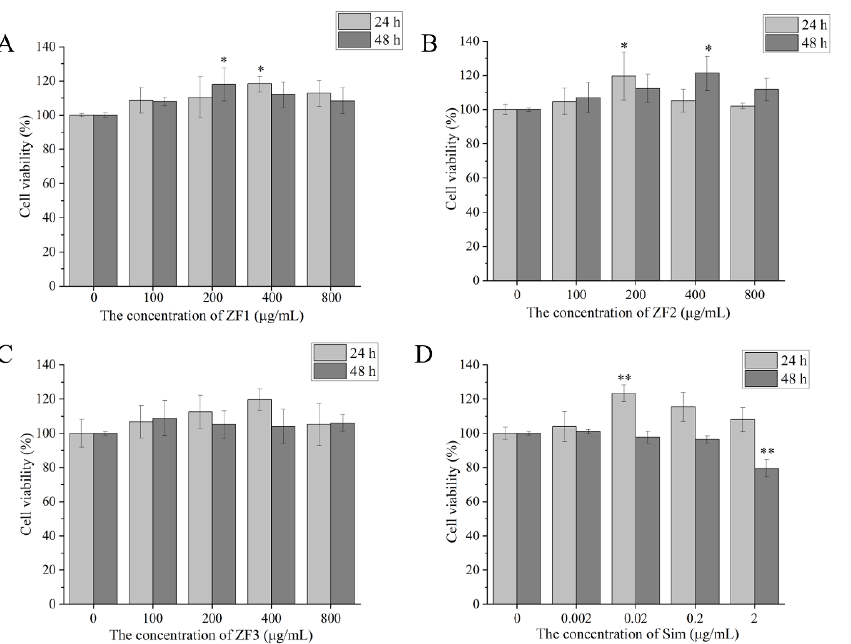
Figure 6. The viability of HepG2 cells treated with different concentrations of ZF1, ZF2, ZF3, and Sim for 24 h and 48 h. ( A ) The viability of HepG2 cells treated with different concentrations (0, 100, 200, 400, and 800 μ g/mL) of ZF1 for 24 h and 48 h; ( B ) the viability of HepG2 cells treated with different concentrations (0, 100, 200, 400, and 800 μ g/mL) of ZF2 for 24 h and 48 h; ( C ) the viability of HepG2 cells treated with different concentrations (0, 100, 200, 400, and 800 μ g/mL) of ZF3 for 24 h and 48 h; ( D ) the viability of HepG2 cells treated with different concentrations (0, 0.002, 0.02, 0.2, and 2 μ g/mL) of Sim for 24 h and 48 h. * indicates p < 0.05, and ** indicates p < 0.01.